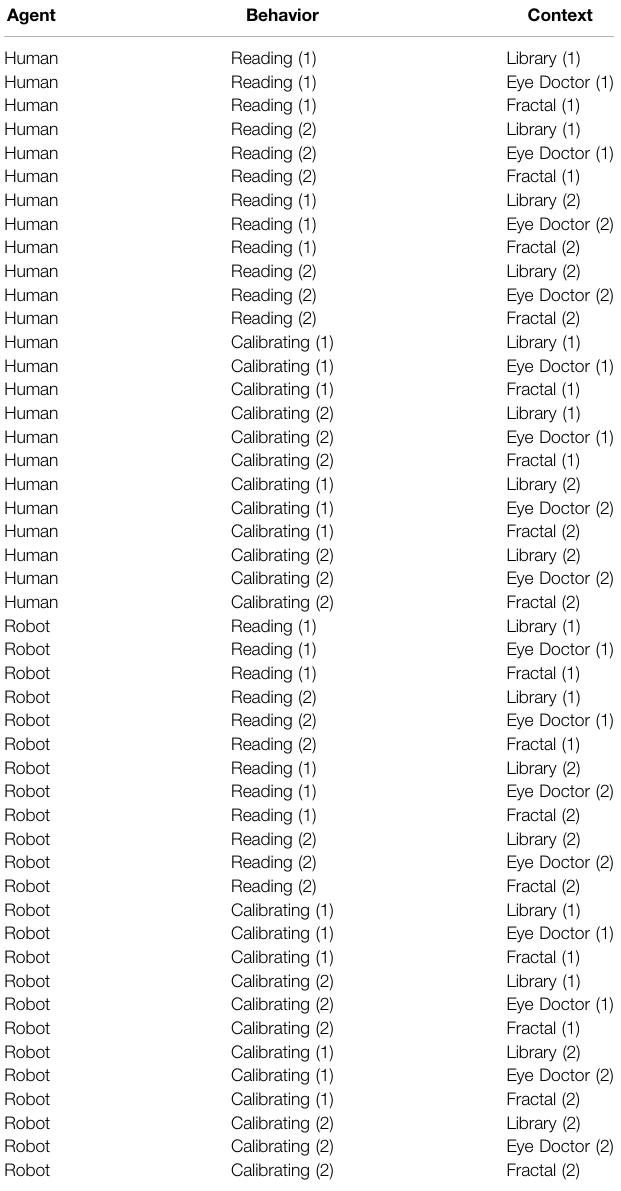
TABLE 1 | Pool of stimuli generated for the current experiment. Numbers in brackets refer to the two different versions of the behaviors and contexts we generated for the current